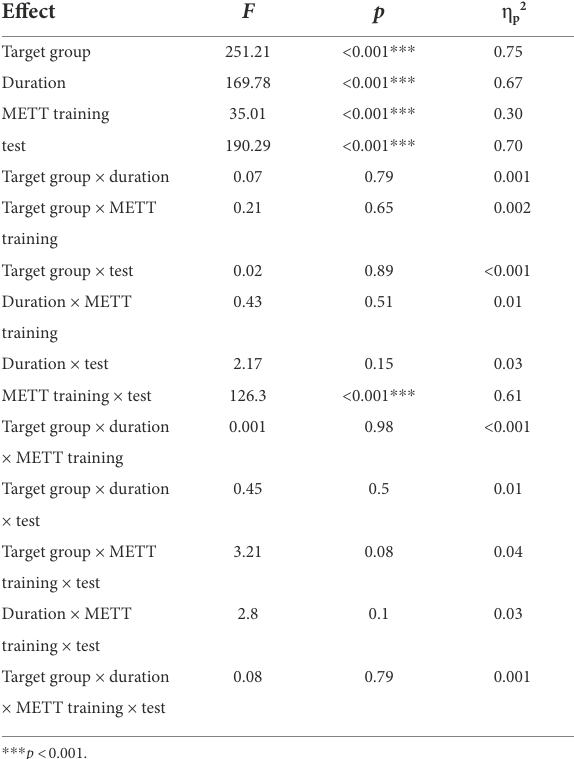
TABLE 2 The results of mixed model ANOVA in Study 2A.